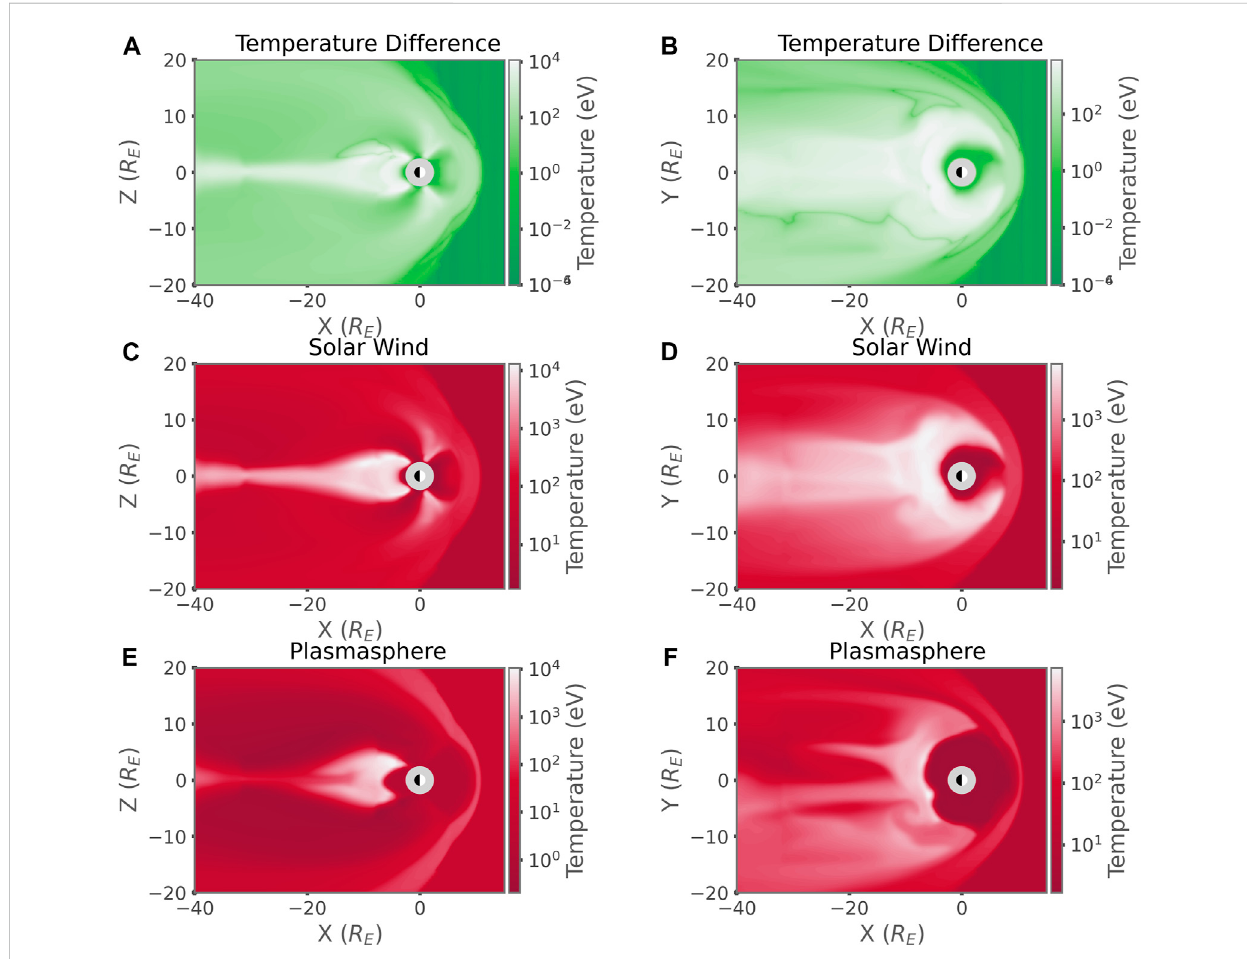
FIGURE 14 (Left Column) Y = 0 Slices, (Right Column) Z = 0 slices. (A , B) Absolute Temperature Difference between the two BATS-R-US fl uids. (C, D) Temperature of the combined solar wind and polar wind fl uid. (E, F) Temperature of the plasmasphere fl